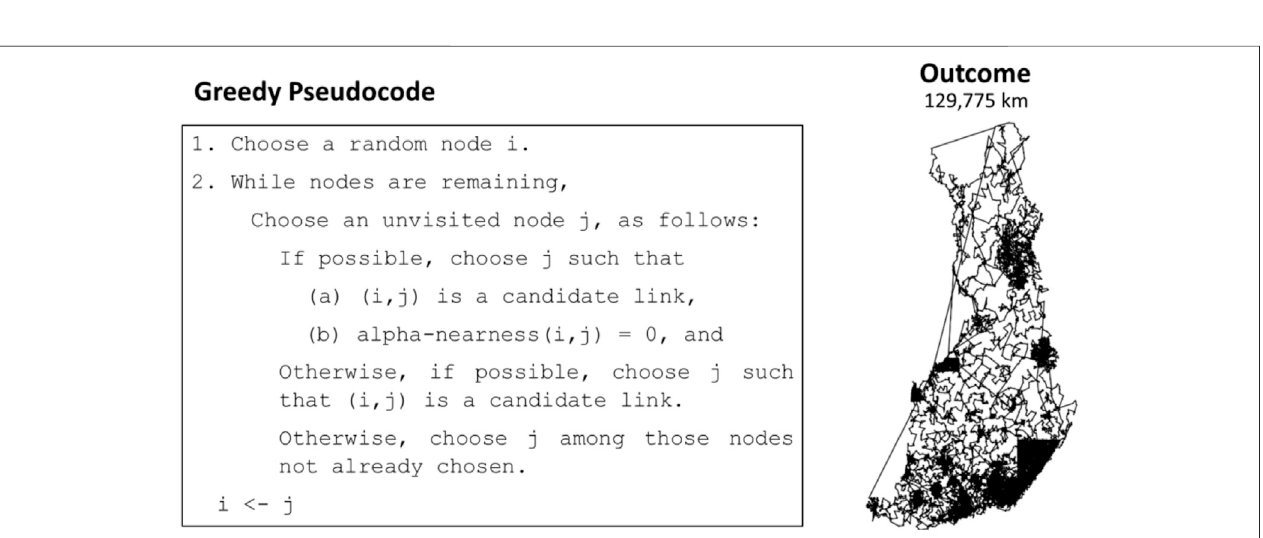
FIGURE 8 | An example of how alpha nearness is calculated for a given link with respect to the minimum 1-tree and the 1-tree that includes the forced link.